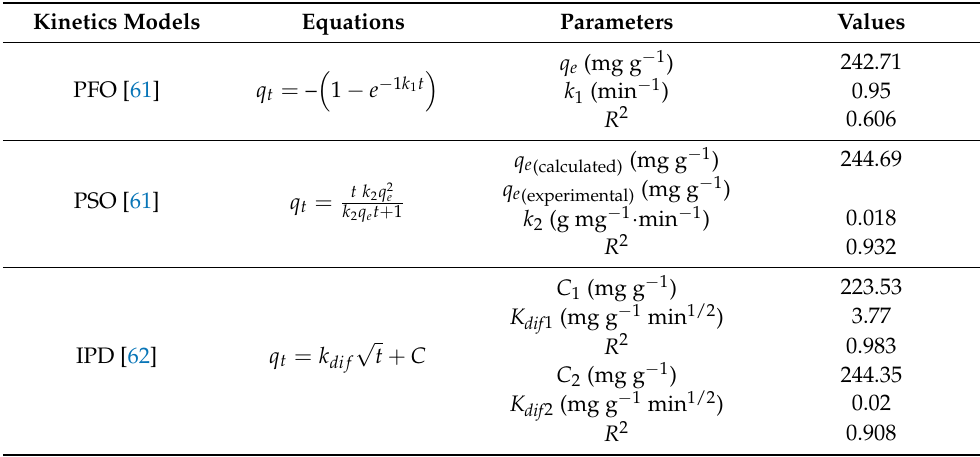
Table 3. Kinetics models for CV adsorption by the V 2 O 5 -g-C 3 N 4